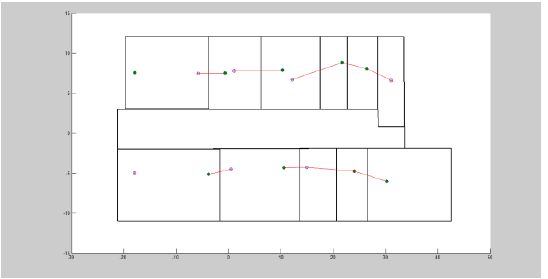
Figure 9. Test case 4 where surveying control points are represented as colored points and connection between dual nodes as red